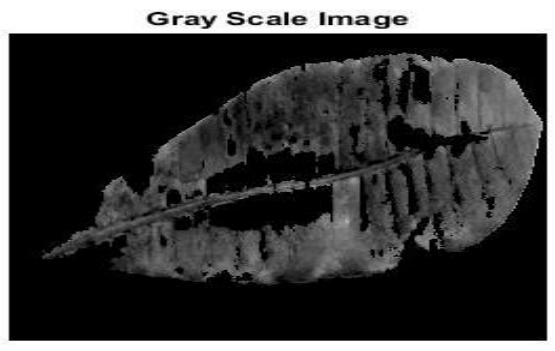
Figure 13. Gray scale image using cluster 1 and 180°co- occurrence angle